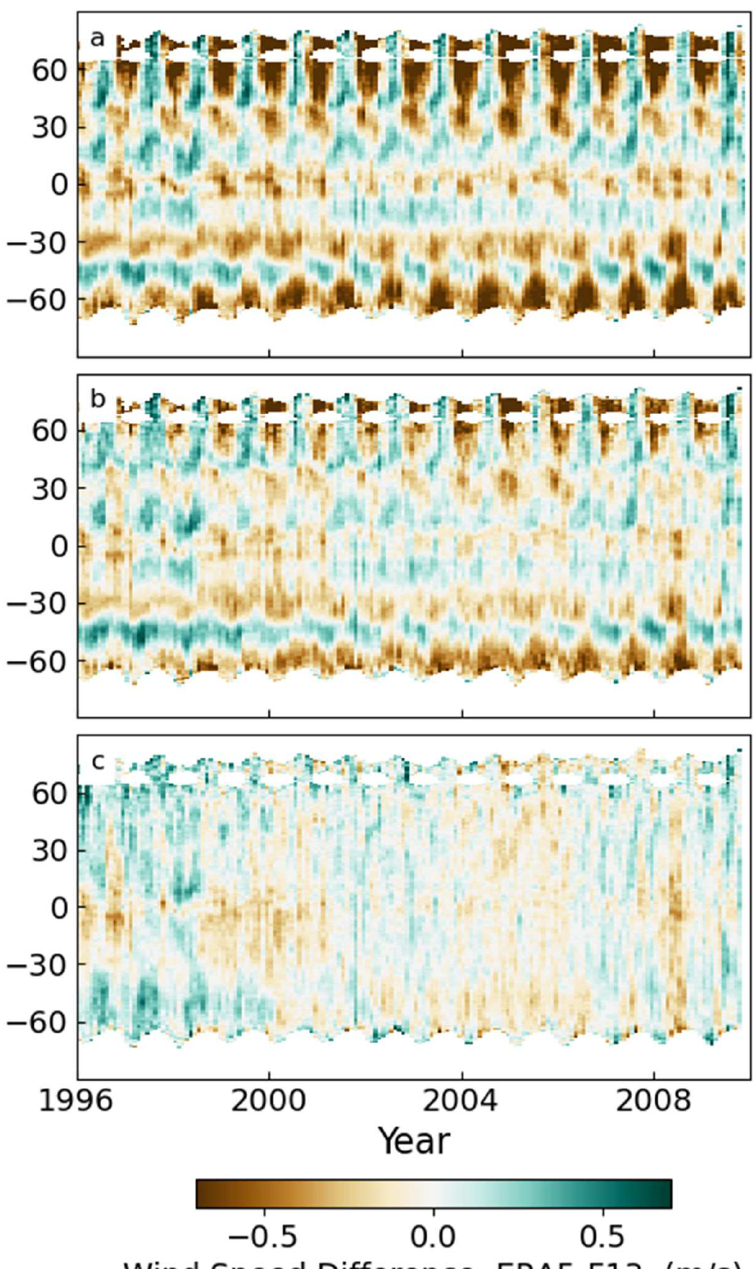
Figure 9. Hovmöller diagrams of the differences between ERA5 and SSM/I F13. ( a ) shows the differences relative to ERA5_OSCAR. There are large seasonally modulated differences poleward of about 25 ◦ S and 25 ◦ N. ( b ) shows the differences relative to ERA5_ADJ. The adjustments applied to ERA5 reduced the ERA5-F13 seasonal differences. After wind speed adjustments were applied to the F13 winds, the seasonal differences are much reduced ( c ). The remaining differences are mostly lower than 0.2 m/s and do not show a consistent seasonal